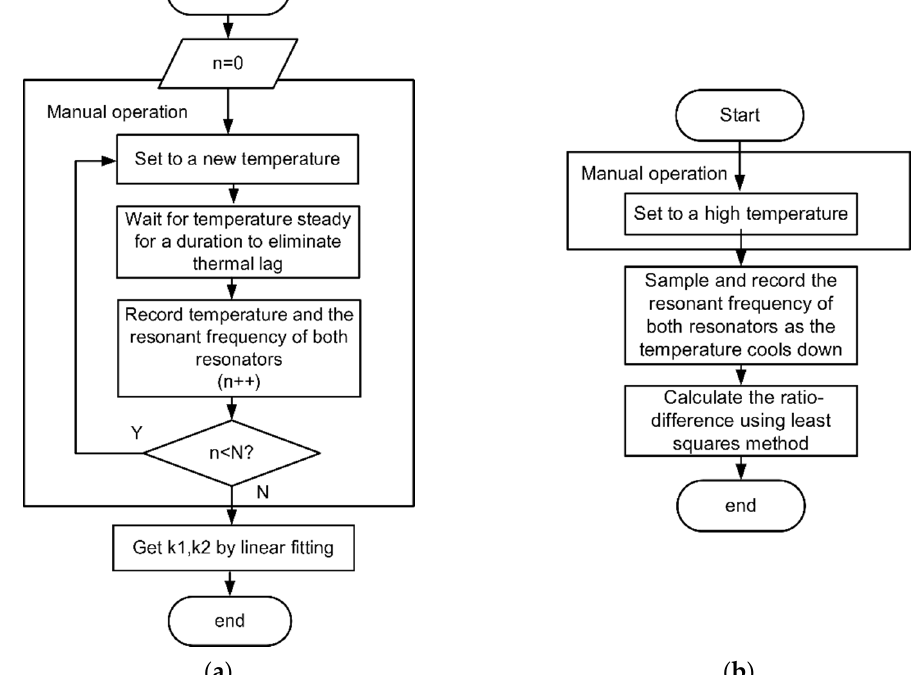
Figure 3. ( a ) Calibration of temperature factor. ( b ) Calibration of temperature difference